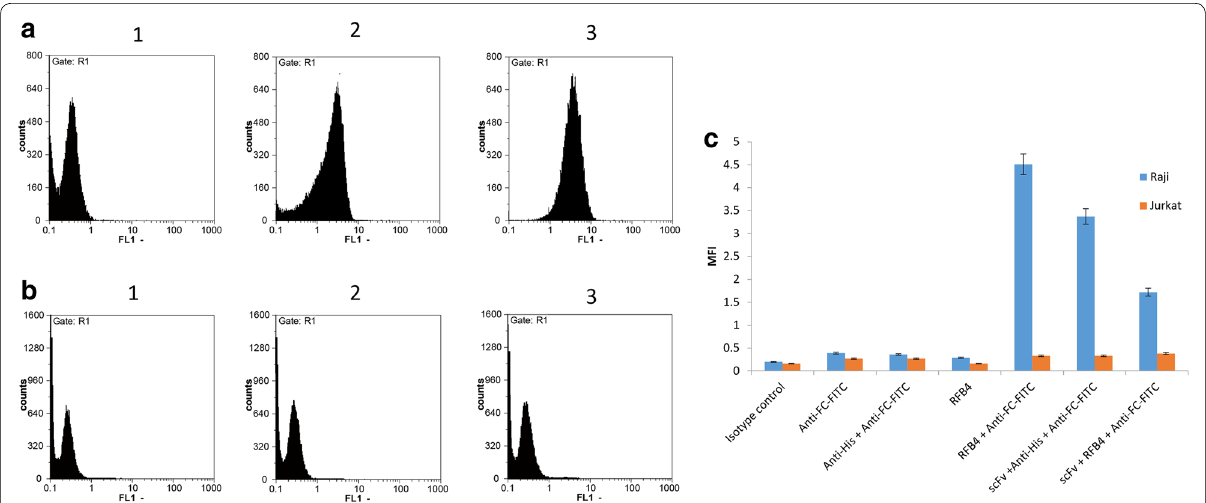
Fig. 5 The flow cytometry analysis of scFv–apoptin binding to Raji or Jurkat cells. The binding of isotype control ( 1 ), scFv–apoptin ( 2 ), and RFB4 ( 3 ), to the cell surface of Raji ( a ) and Jurkat ( b ) cells is shown. The recombinant scFv–apoptin specifically binds to the CD22 positive Raji cells as presented by shift in fluorescence value in Raji cells in comparison with the lower value of the fluorescence intensity measured from the Jurkat cells. c Plot of the MFI value of Raji and Jurkat cells incubated with presented